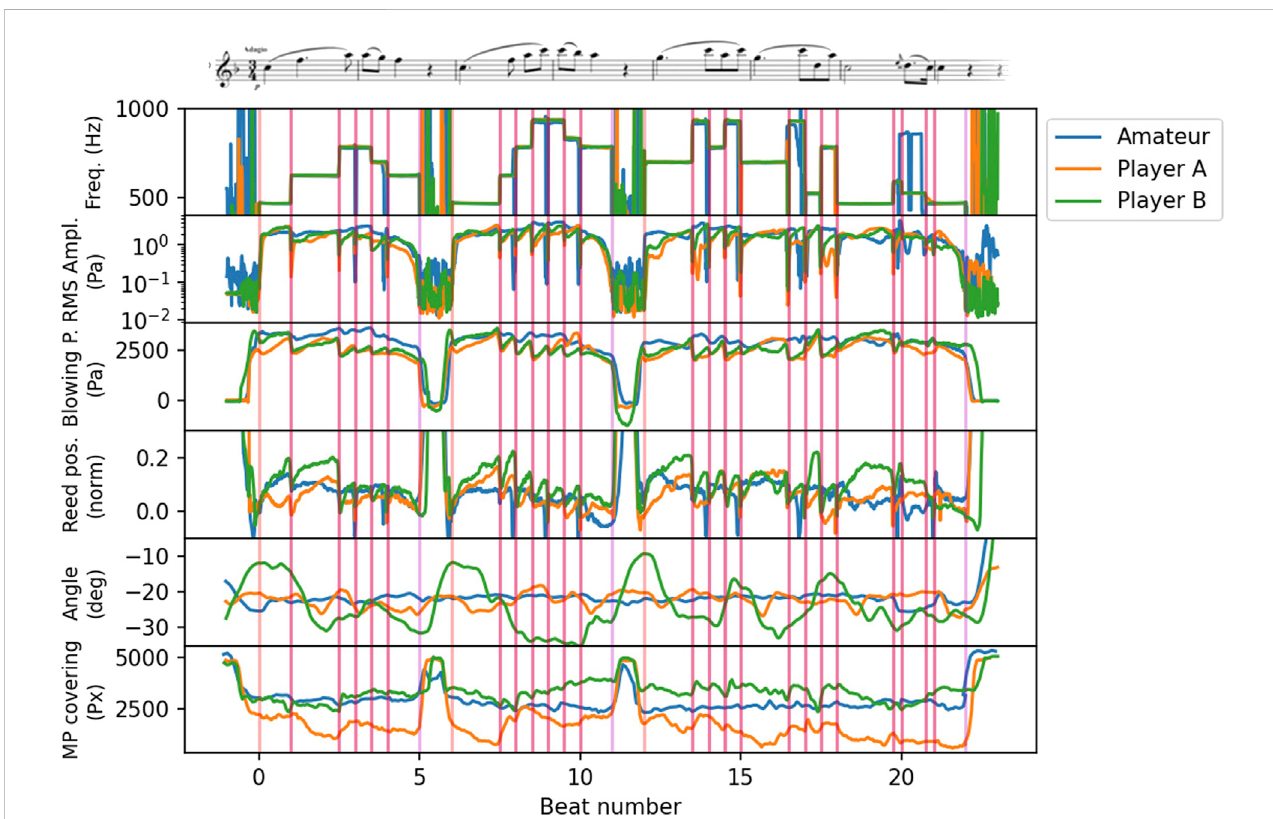
FIGURE 10 Comparison of excerpts played by three different players, including one amateur player. Such plots allow the identi fi cation of notable differences between an amateur player and a pair of expert, professional